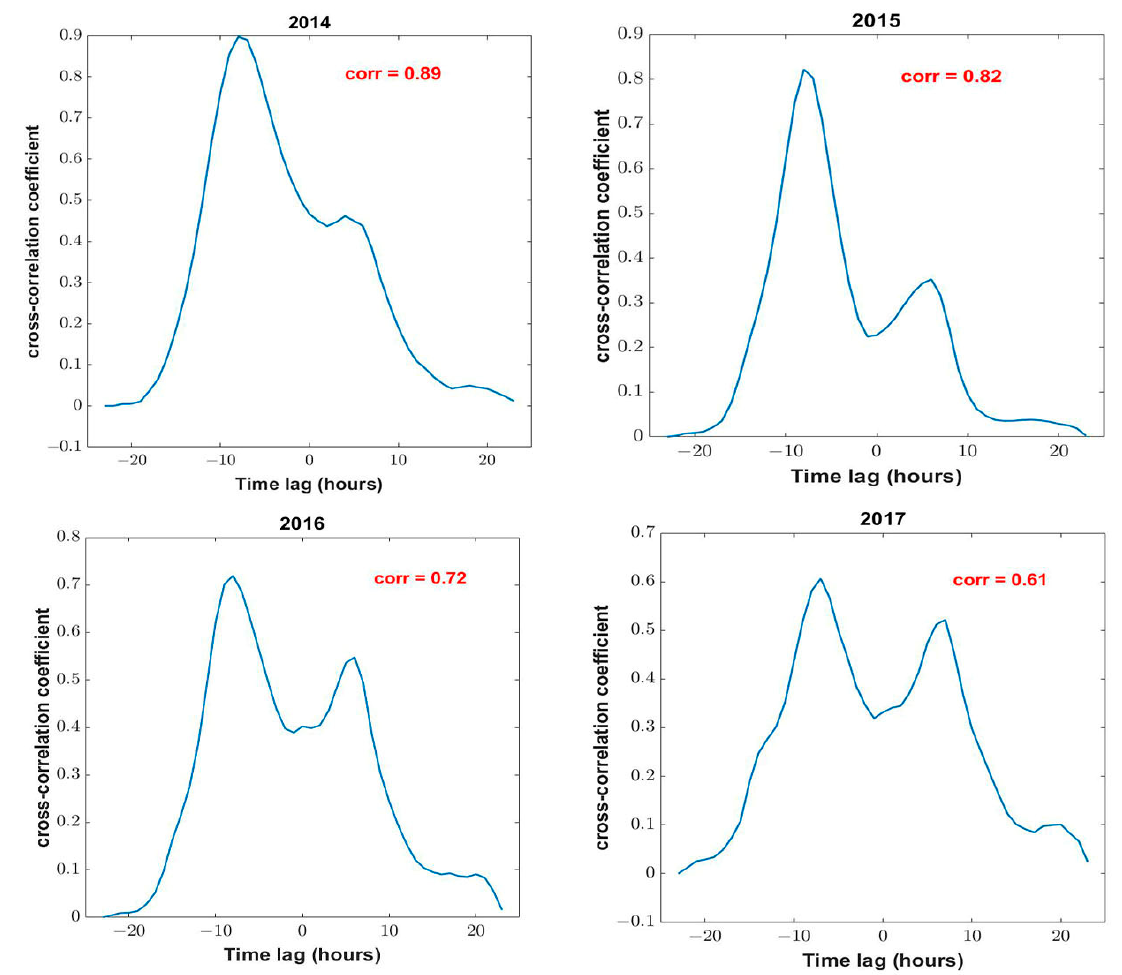
Figure 5. Cross-correlation of lightning and ROTI avg counts from left panels in Figure 2.